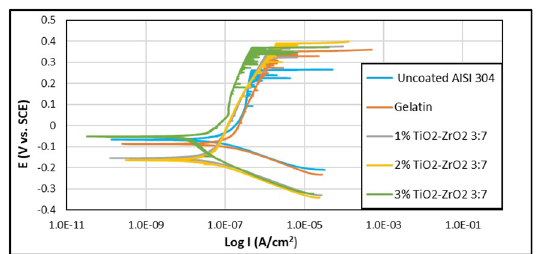
Figure 10. Potentiodynamic polarization curves of the AISI 304 steel coated with hybrid TiO and different weight percentages (1% wt., 2% wt., 3% wt.) of nanoparticles dispersed in gelatin.